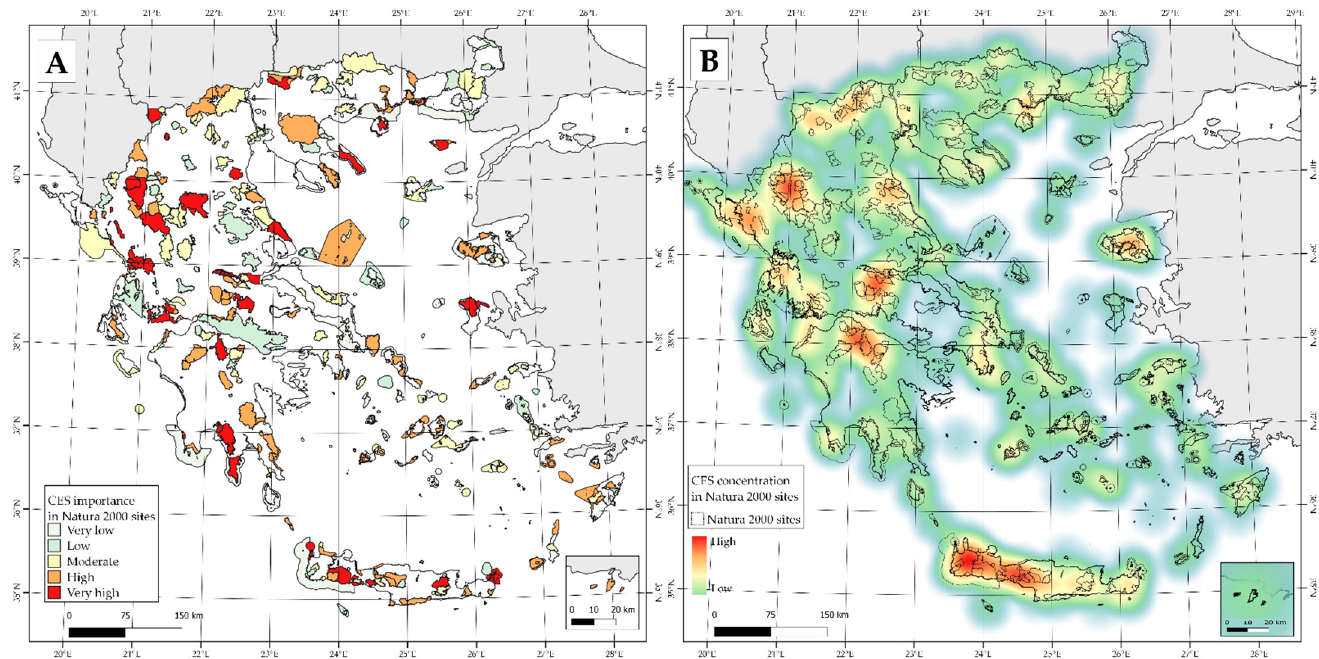
Figure 4. Cumulative CES importance gradient map ( A ) and heat map ( B ) per Natura site, including all five CES indicator categories as developed in the current inventory and assessment. The heat map uses a 40 km radius to define levels of relative concentration of CES highly-valued sites.